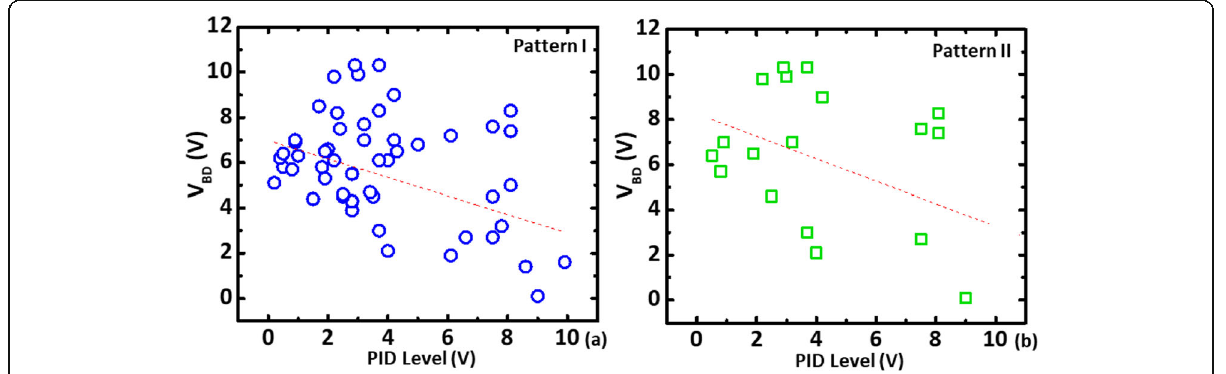
Fig. 6 Correlations between VBD from PID levels for a pattern I and b pattern II samples, respectively [10 –